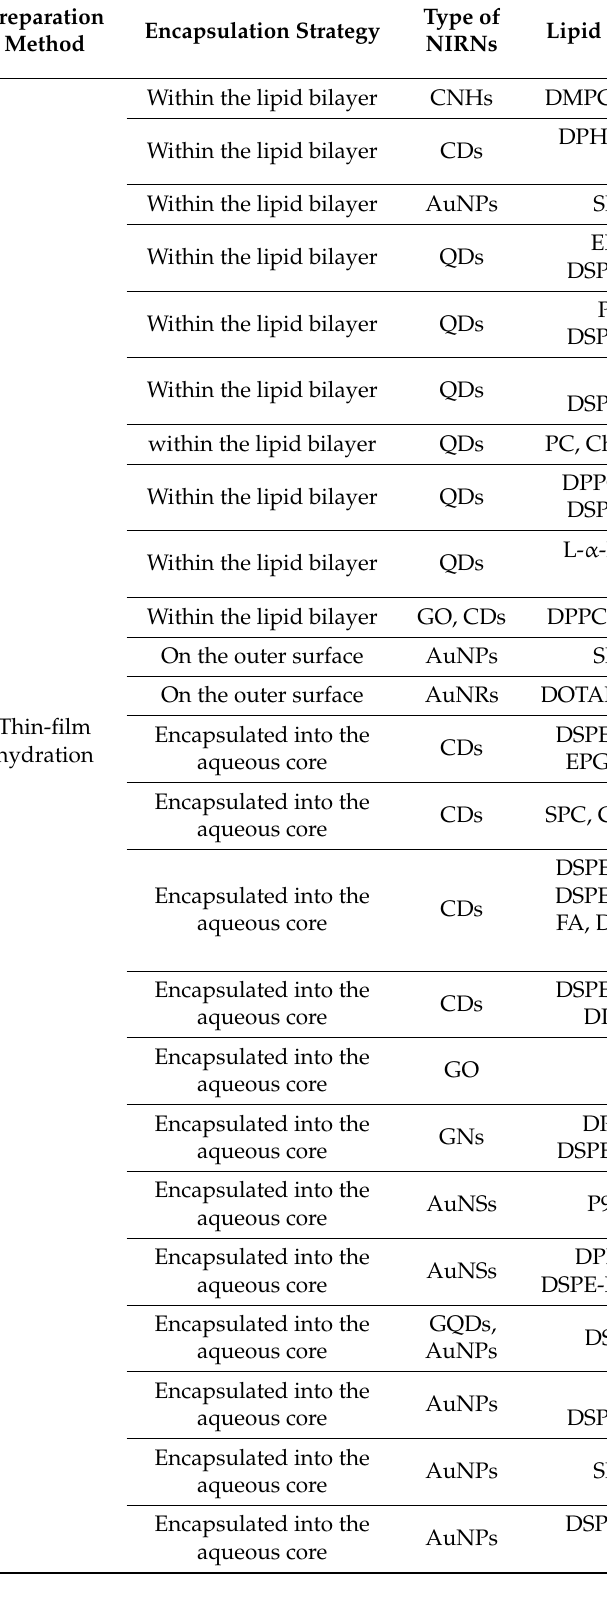
Table 1. Different NIRN-Lips in terms of preparation method, encapsulation strategy, type of NIRNs and lipid composition.